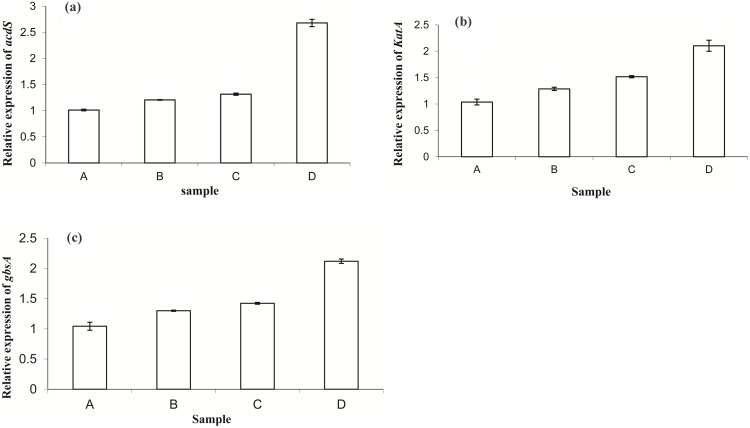
Relative gene expression level of, a) acdS, b) katA and c) gbsA in P. aeruginosa (GGRJ21) growing in different osmotic stress condition.A-GGRJ 21 grown in normal NB medium, B-GGRJ21 grown in –0.3mPA, C-GGRJ21 grown in 0.49mPA and D-GGRJ21 grown in –0.73mPA.